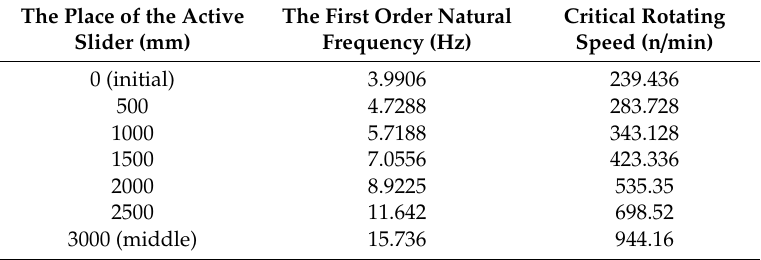
Table 1. The different first-order natural frequencies of the lead screw without the support slider and corresponding critical rotating speed. corresponding critical rotating